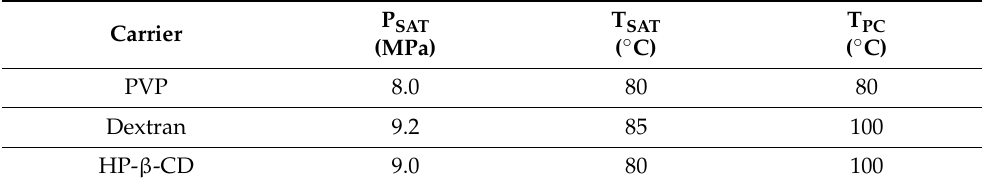
Table 2. Fixed operating conditions. P SAT : pressure in the saturator; T SAT : temperature in the saturator; T PC : temperature in the precipitation chamber; GLR: gas-to-liquid ratio. P SAT Carrier (MPa) PVP